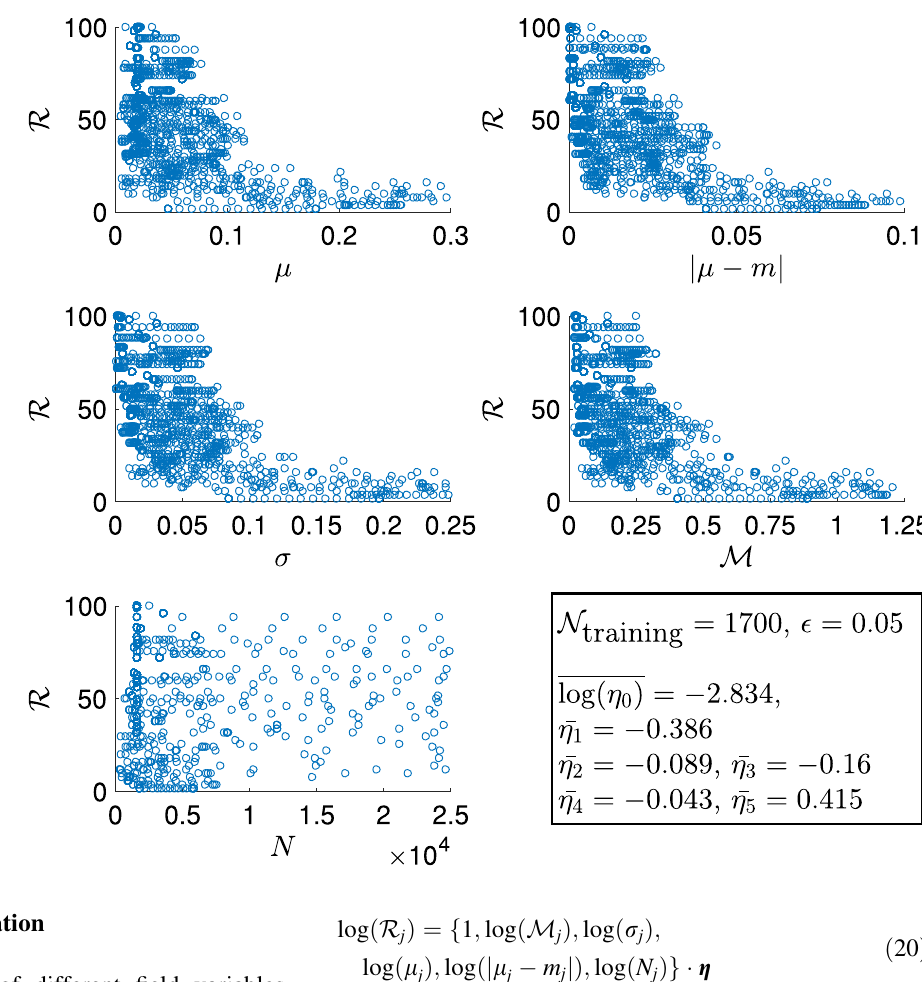
Fig. 9 Plots showing the ‘‘true’’ training compression ratio R as a function of the gradients statistics. Results are